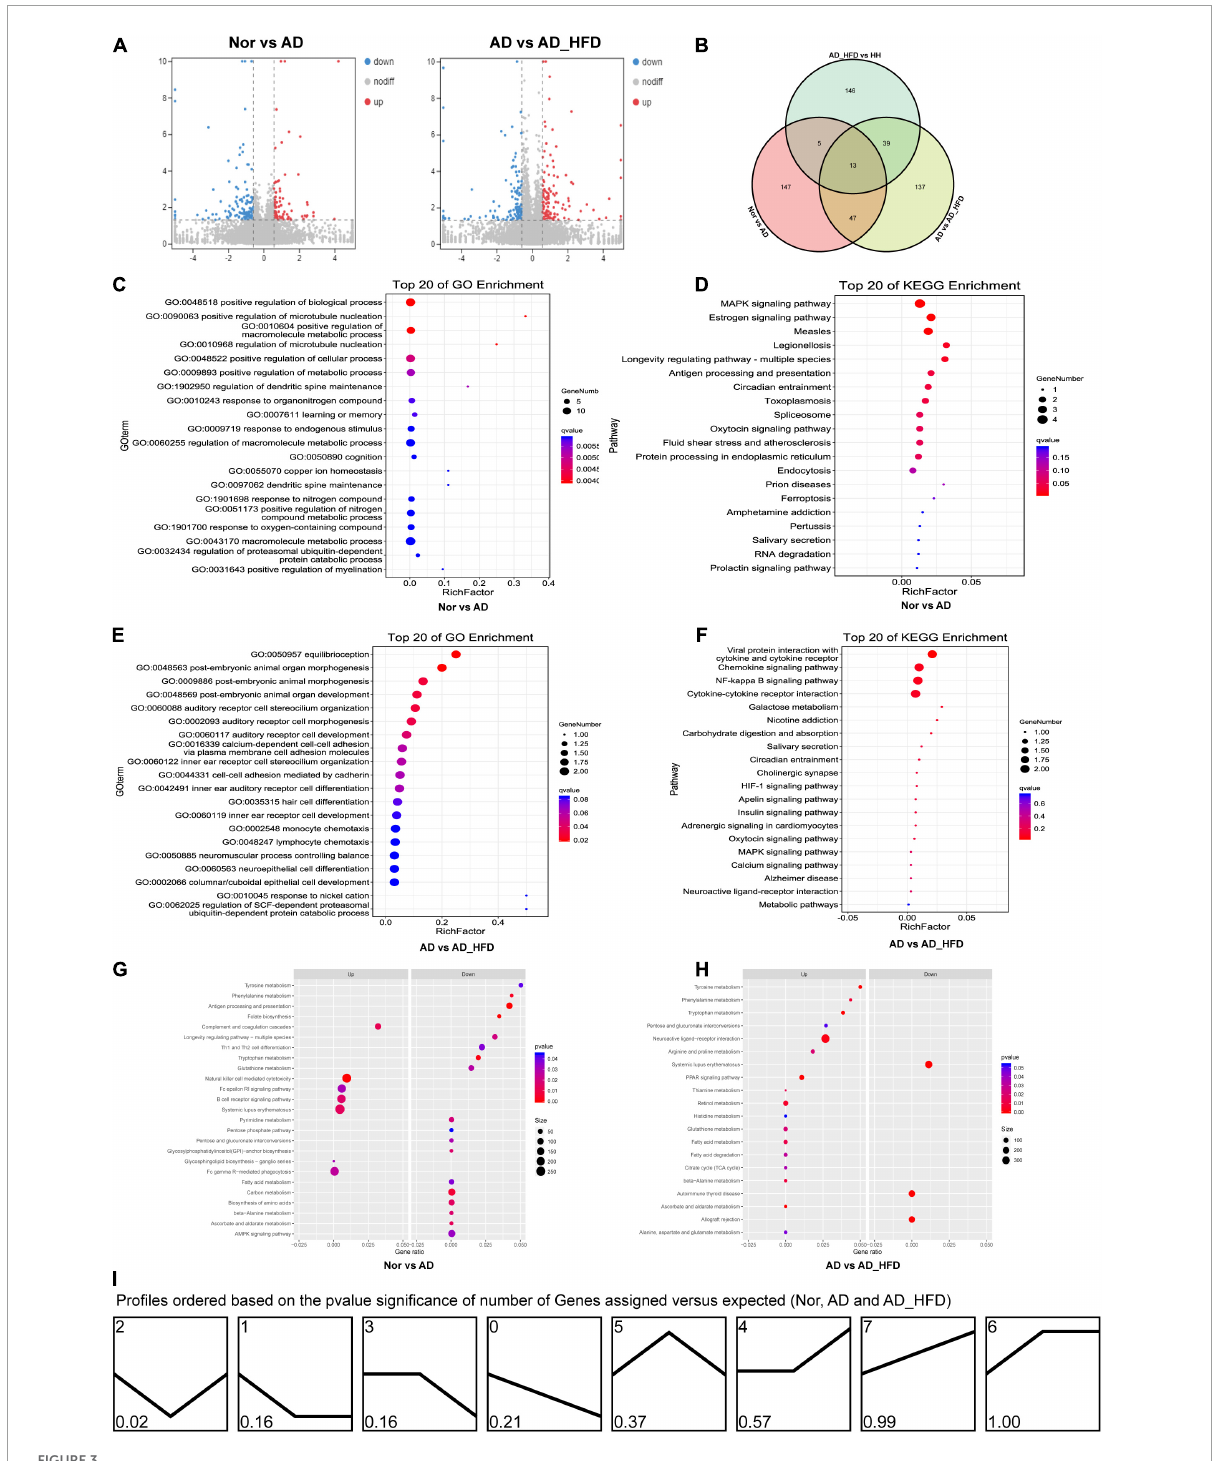
FIGURE3 Transcriptome analysis. (A) Volcano plots of differentially expressed mRNA between groups in transcriptome. (B) Venn diagram showing the distinct and overlapping differential genes between groups of the transcriptome. (C) GO enrichment analysis of the transcriptome between the Nor and AD groups. (D) KEGG pathway analysis of the transcriptome between the Nor and AD groups. (E) GO enrichment analysis of the transcriptome between the AD and AD_HFD groups. (F) KEGG pathway analysis of the transcriptome between the AD and AD_HFD groups. (G) GSEA of the transcriptome between the AD and AD_HFD groups. (H) GSEA of the transcriptome between the AD and AD_HFD groups. (I) Trends in genetic variation among the Nor, AD and AD_HFD